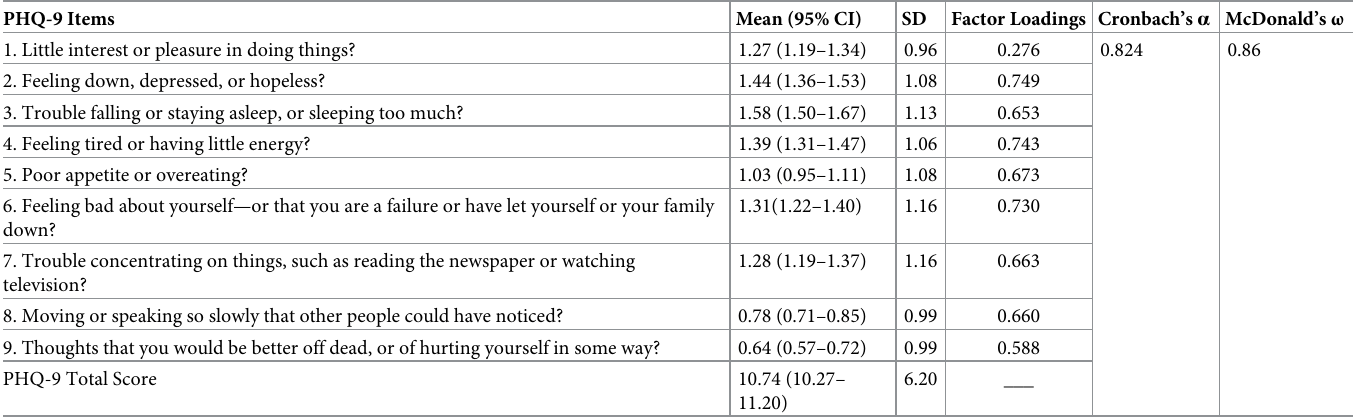
Table 2. Characteristics of items and total PHQ-9 scale.